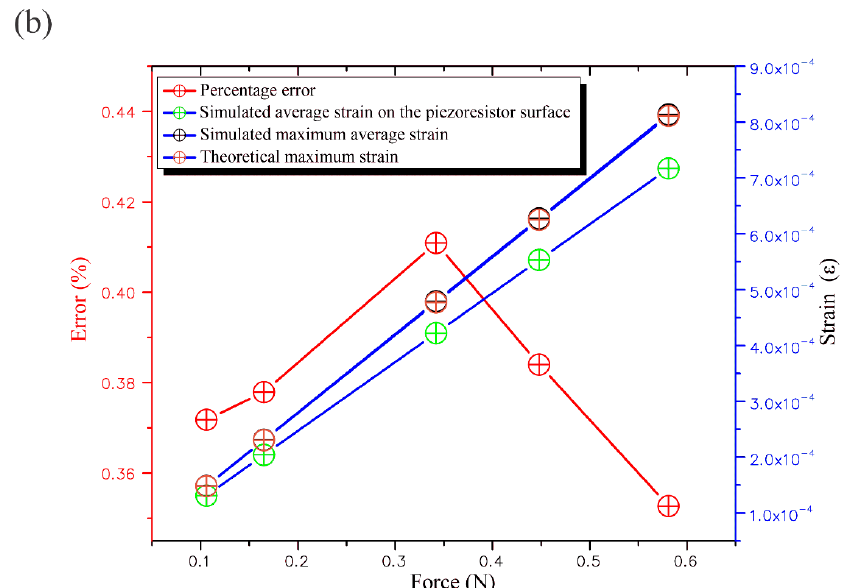
Figure 5. ( a ) Results of the finite element analysis (FEM) of the piezoresistor strain caused by the application of forces at the free end of the cantilever; ( b ) average strain extracted via simulation of the ZnO:F patterned surface versus theoretically calculated strain.